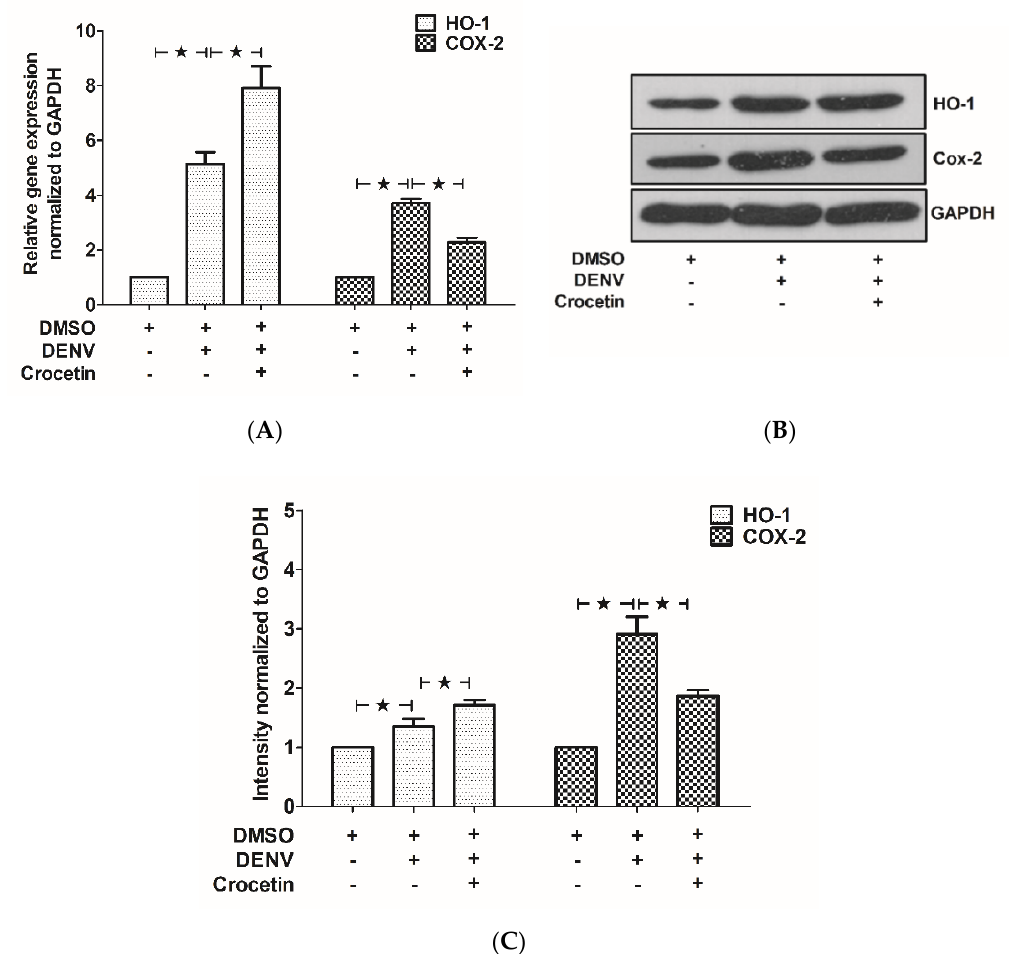
Figure 6. Crocetin increased HO-1 expression, but reduced COX-2 expression in the livers of DENV-infected mice. BALB/c mice were infected with DENV-2 (4 × 10 5 FFU/mL) and then treated with crocetin (50 mg/kg) dissolved in 2% DMSO. DENV-infected 2% DMSO-treated and mock-infected 2% DMSO-treated groups of mice were used as positive and negative controls, respectively. RNA samples prepared from liver tissues were converted to cDNA. RT-PCR was conducted, and the Ct values were normalized to that of GAPDH. For the protein expressions, Western blot analysis was conducted with protein samples obtained from liver homogenates, and the blots obtained were quantitated by ImageJ densitometry analysis. The result shows ( A ) mRNA expressions and ( B ) protein expressions of HO-1 and COX-2, and ( C ) represents the densitometry analysis of the immunoblots. The black star represents, those groups were compared and found to be significant.